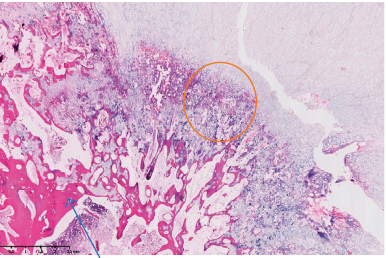
Figure 5: Histopathological section of the osteochondroma il- lustrating the bony trabeculae (blue arrow) and the cartilage component of the lesion (orange